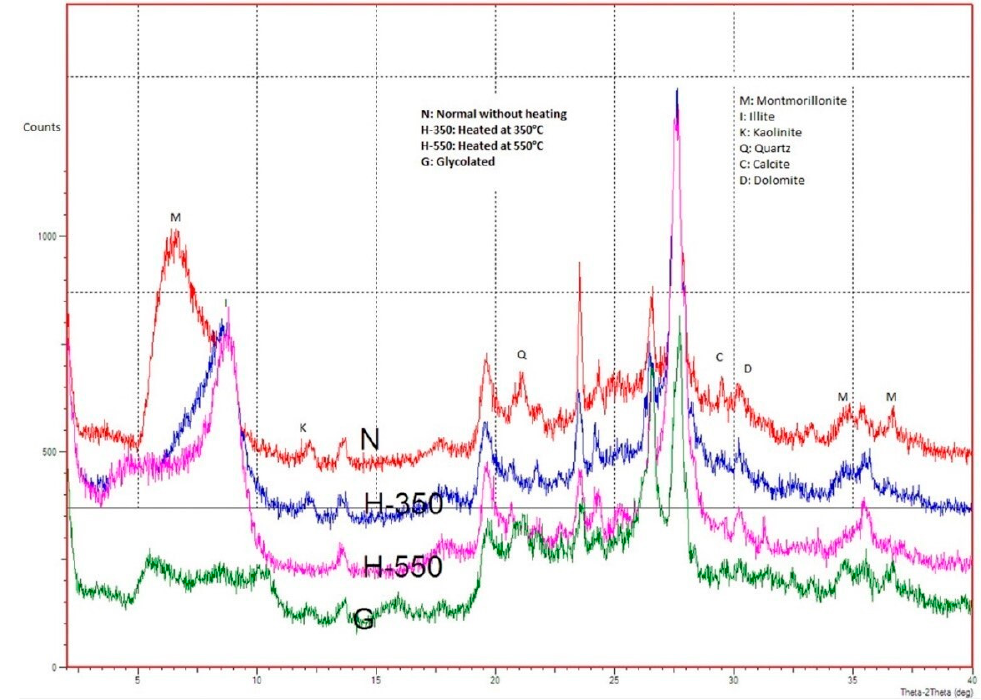
Figure 2. Representative XRD patterns of oriented samples for Al-Azraq NBC. Table 3. Chemical analysis of NBC by XRF.